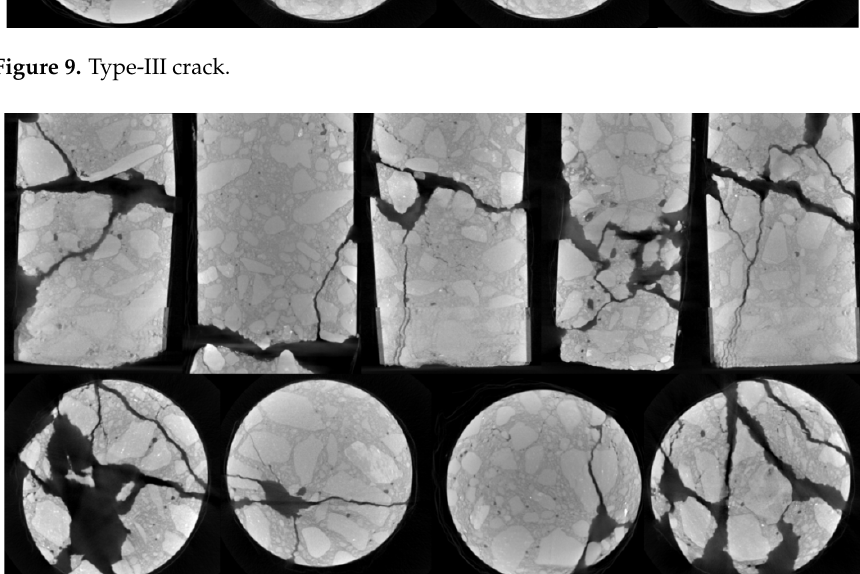
Figure 10. Type-IV crack .